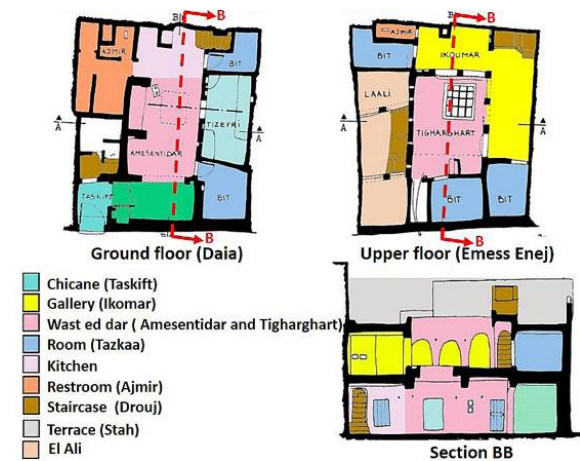
Figure 3. The architectural composition of a M’zab house (Bousquet, 2002; treated by the